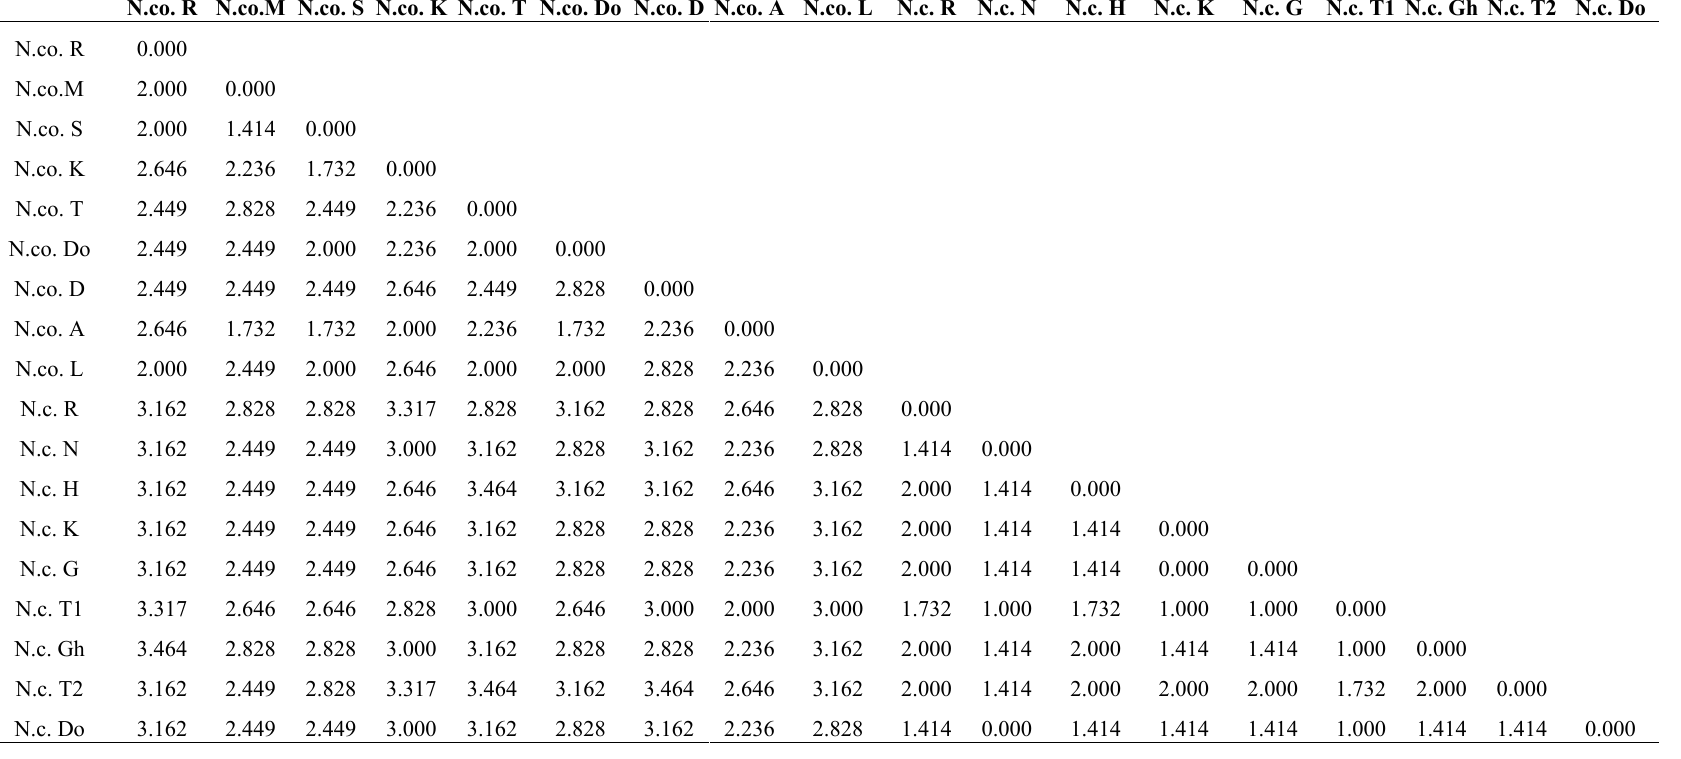
Table 4 Euclidean distances; pair-wise comparisons of N. complanata and N. crispa populations based on isoenzyme